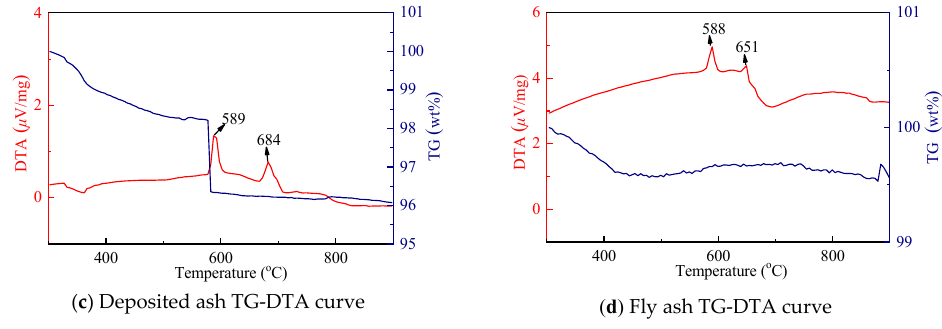
Figure 14. TG-DTA curve in various forms of soda ash.